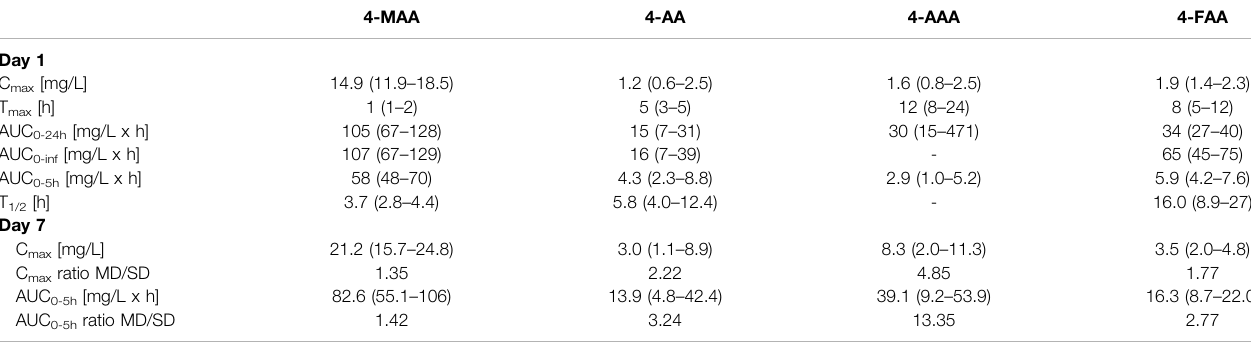
TABLE 2 | Pharmacokinetic parameters after a single oral dose of 1,000 mg metamizole ( n (cid:1) 8) on day 1 and after multiple doses (1,000 mg TID) on day 7.